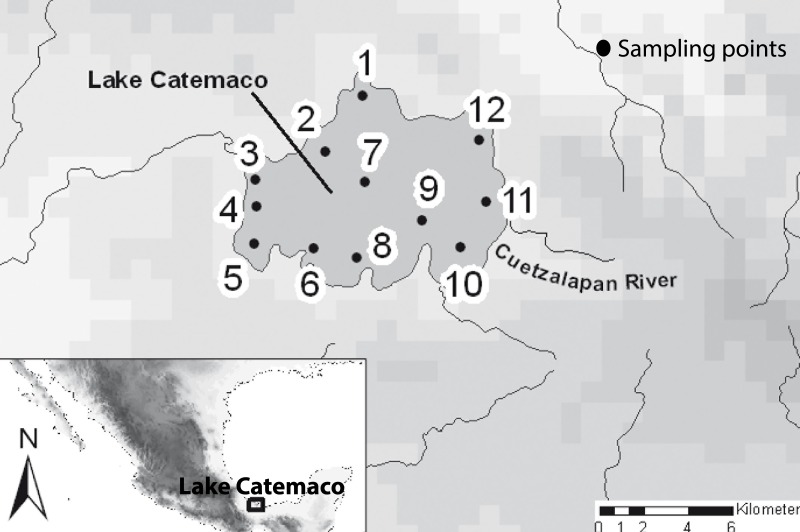
Map of the sampled localities in the Lake Catemaco.(1) Changos Island, (2) Agatepec Island, (3) Finca, (4) Maxacapan, (5) Victoria, (6) Pozolapan, (7) Center of the Lake, (8) Mimiahua, (9) Cuetzalapan Lago, (10) Margarita, (11) Cuetzalapan Río, and (12) Oxochapan.